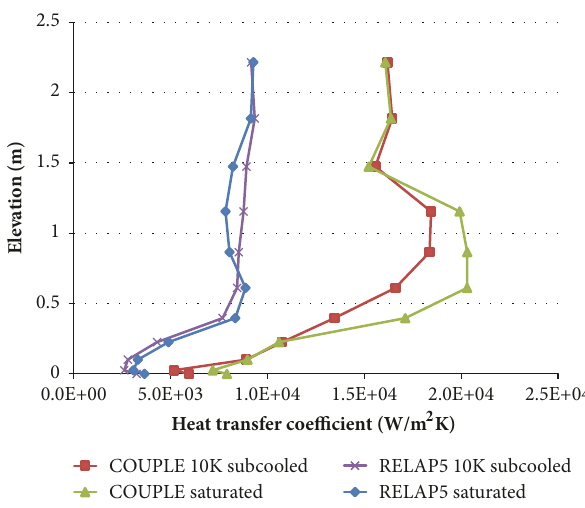
Figure 15: Heat transfer coefficient from external wall to ex-vessel volume for each case.